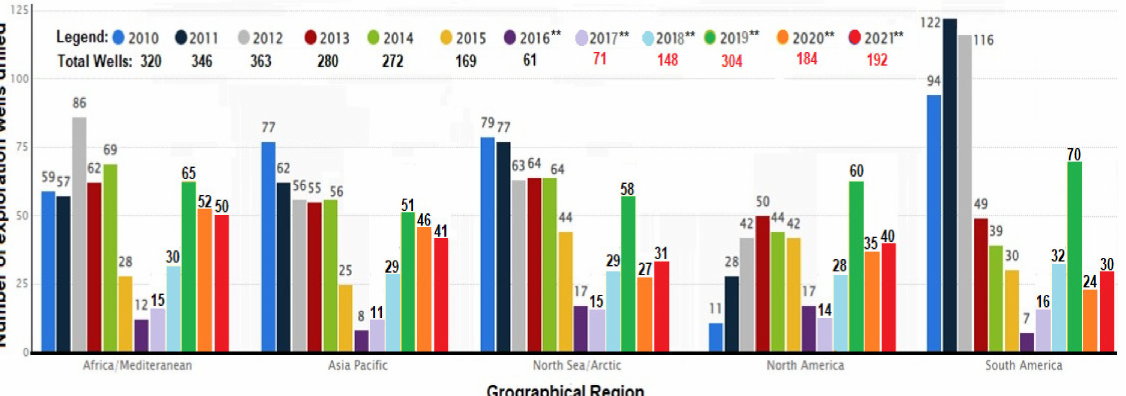
Figure 2. Global deep water exploration wells drilled by region for 2010–2021 with forecast for 2016**–2021** using data from QuestOffshore (Image Courtesy: Author